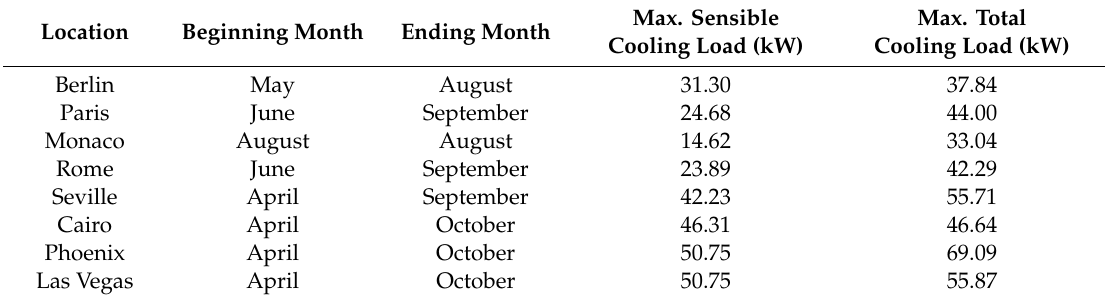
Table 4. Periods in which the fresh air cooling is needed and the maximum cooling